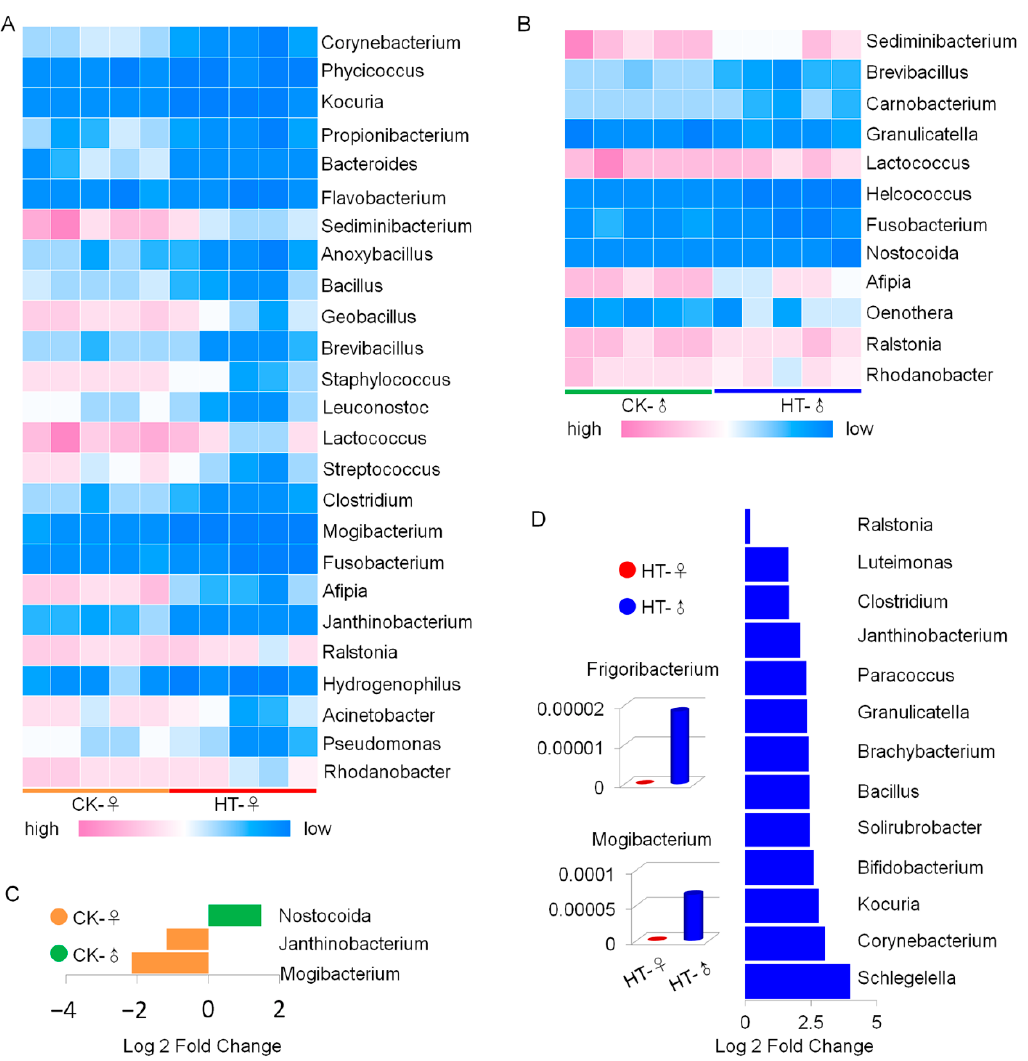
Figure 4. Differential microbes in the microbial genera levels in the silkworm gut caused by high temperature. ( A ) Microbes at the genus level. High temperature caused significant differences in female silkworms ( p < 0.05). ( B ) At the genus level, high temperature caused significant differences in male silkworms ( p < 0.05). ( C ) At the genus level, there were significant differences in the intestinal microbes of the silkworm in the control group ( p < 0.05). ( D ) At the genus level, there were significant differences in the microbes in the silkworm intestines in the high-temperature group ( p < 0.05). The bar plot shows gut microbiota at the genus level that were significantly enriched ( p < 0.05) as determined by one-way ANOVA. Fold change of the main discriminant between CK- ♀ and CK- ♂ ; fold change of the main discriminant between HT- ♀ and HT- ♂ .